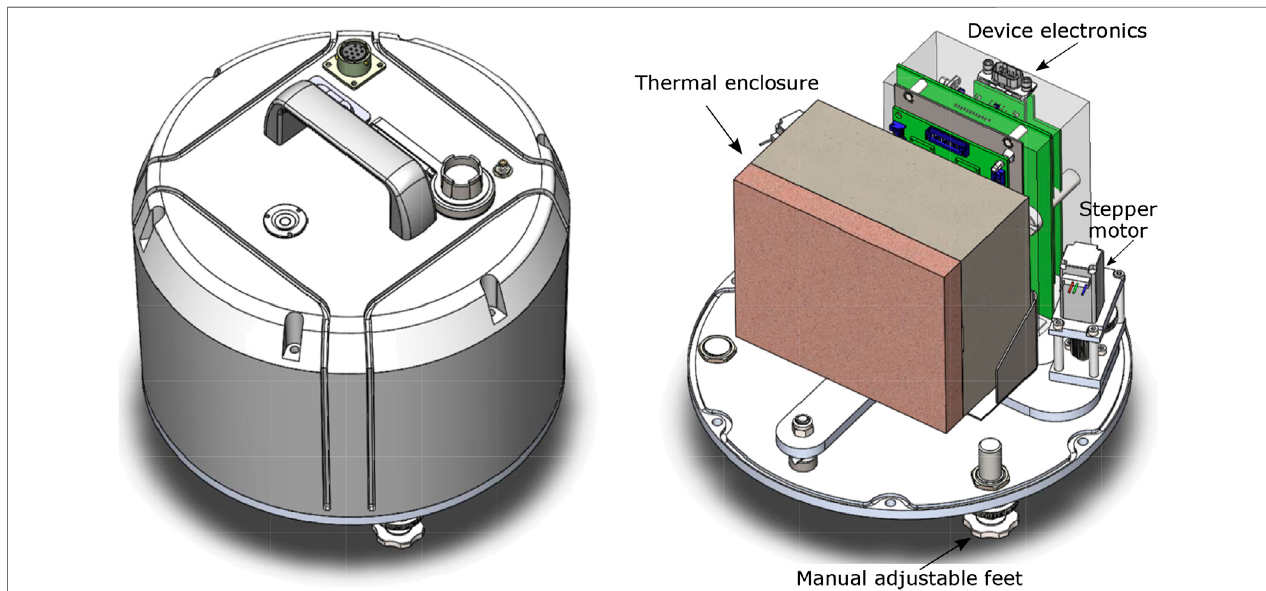
FIGURE 5 | Three-dimensional rendering of the microelectromechanical systems gravimeter enclosure. The diameter and height (including the top handle) of the enclosure are, respectively, about 25 and 22 cm.